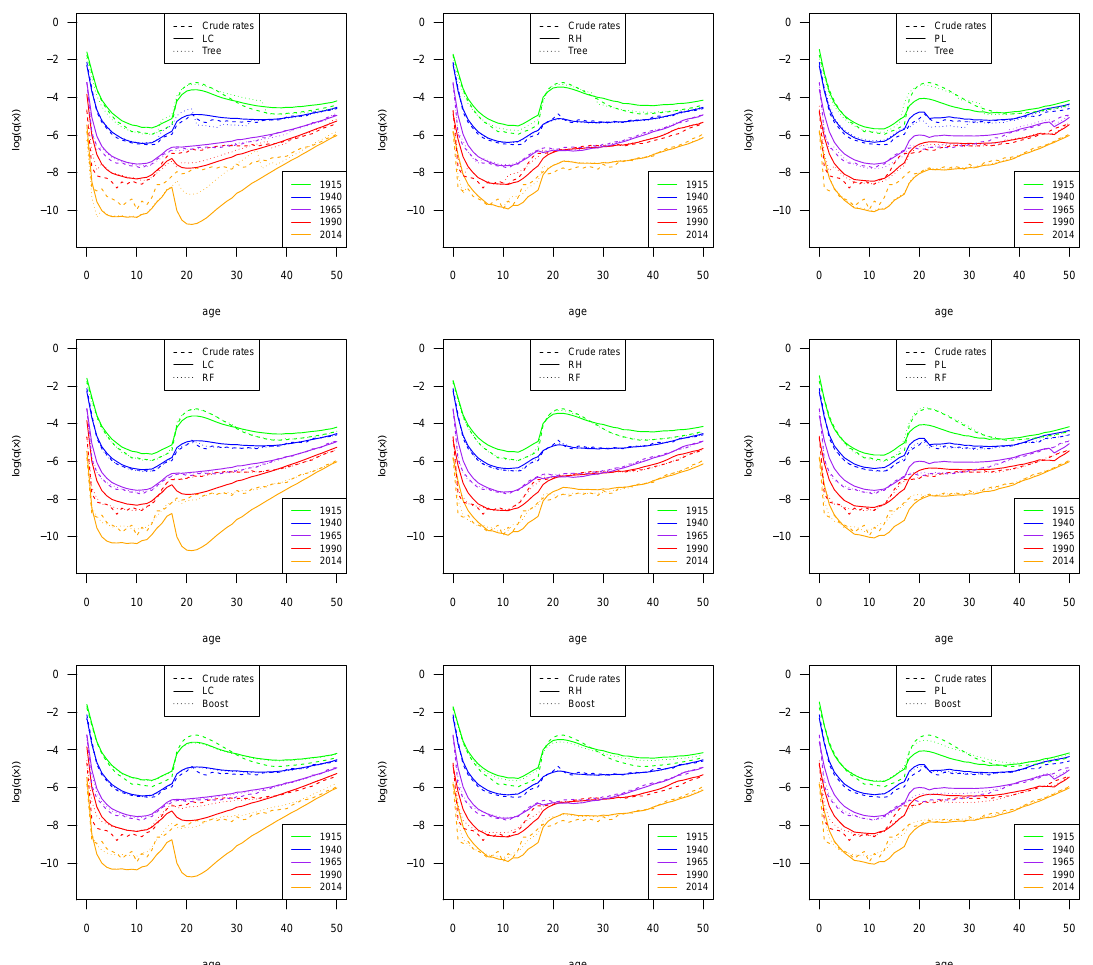
Figure 4. Logarithm of mortality rate, ages 0–50. Italian male population. Examples for cohorts born in 1915, 1940, 1965, 1990, and 2014.